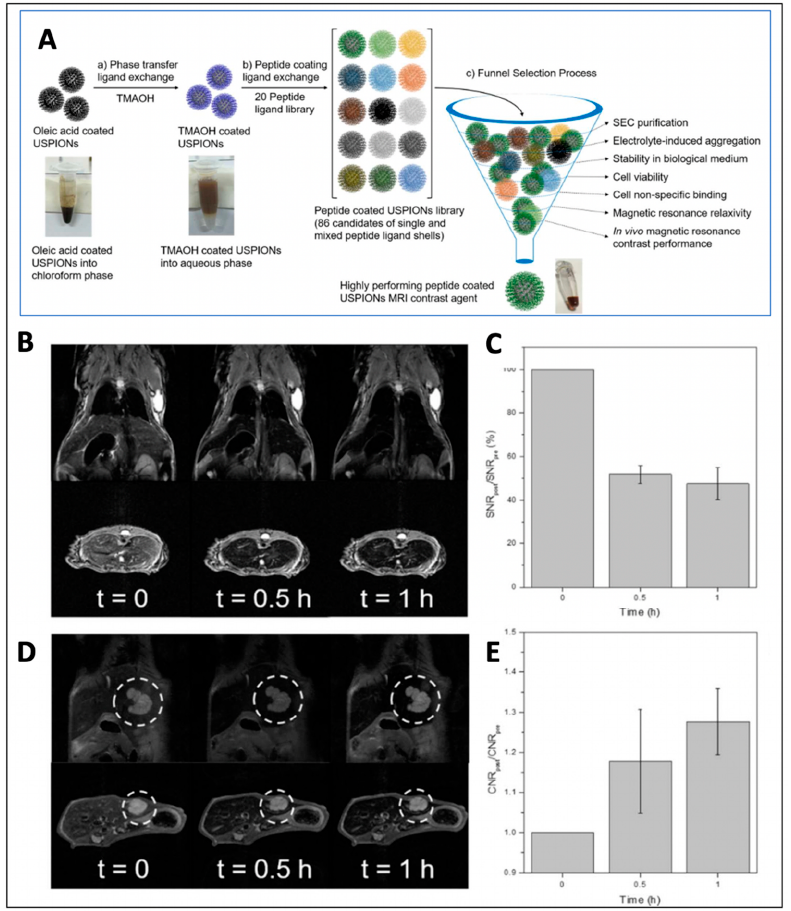
Figure 6. ( A ) Schematic illustration of preparation of peptide-coated USPIONs as MRI contrast agents. (a) Phase transfer of oleic acid coated USPIONs from chloroform to aqueous medium by ligand exchange with TMAOH; (b) Peptide coating by ligand exchange; (c) Determining best-per- forming peptide-coated USPION (i.e., 2PG-S*VVVT-PEG4-ol coated USPION) by funnel selection process for in vivo MRI application. ( B ) In vivo MR images of NCr nude mice in upper (coronal) and lower (transverse) plane after 0, 0.5, and 1 h of intravenously injecting 2PG-S*VVVT-PEG4-ol coated USPIONs. ( C ) Quantitative analysis of liver contrast in NCr nude mice after accumulation of peptide-coated USPIONs (dose: 1.0 mg Fe per kg). ( D ) In vivo MR images in upper and lower plane of orthotopic xenograph liver tumor model after 0, 0.5, and 1 h of intravenously injecting 2PG- S*VVVT-PEG4-ol coated USPIONs. ( E ) Quantitative analysis of contrast-to-noise ratio (CNR) after accumulation of peptide-coated USPIONs (dose: 2.0 mg Fe per kg). (TMAOH: Tetramethylammo- nium hydroxide; 2PG = (PO 3 H 2 )-O-CH 2 -CO-; S* = Ser(PO 3 H 2 ); PEG4-ol = − NH-(CH 2 -CH 2 -O) 3 -CH 2 - CH 2 -OH; T: Threonine; V: Valine). Reproduced with permission from Ref. [119]. Copyright 2018 American Chemical Society.